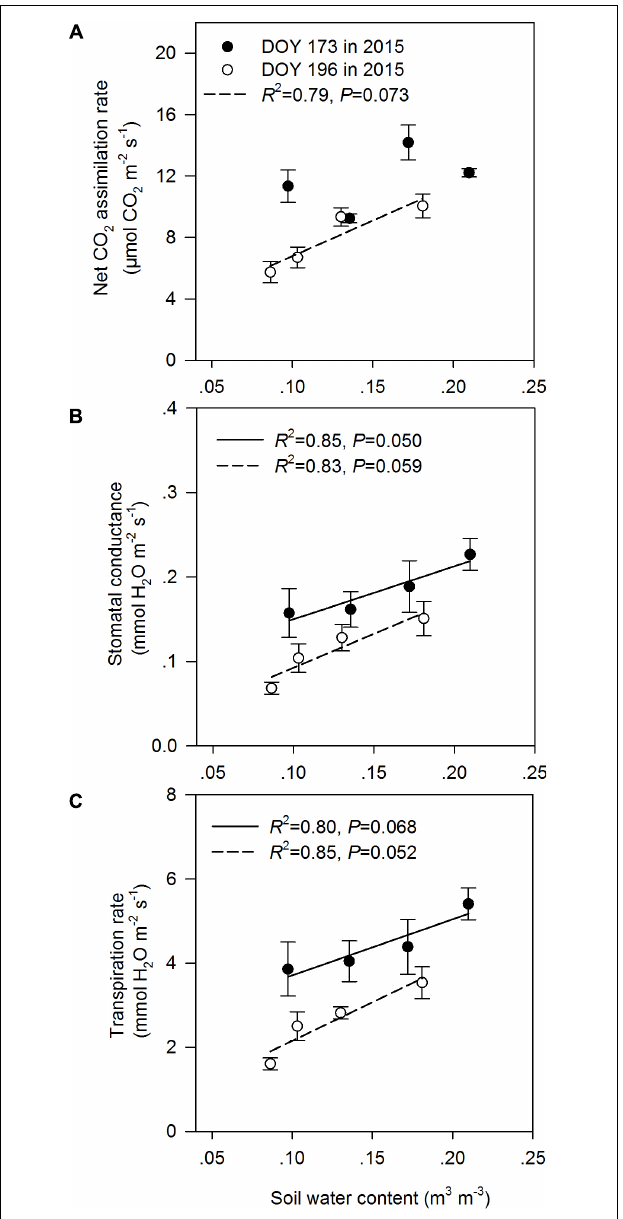
FIGURE 3 | Relationships between leaf gas exchange parameters [ (A) net CO 2 assimilation rate, (B) stomatal conductance, and (C) transpiration rate] and soil water content at the middle (DOY 173) and the end (DOY 196) of the drought period. The error bars represent standard errors of means ( n = 6).